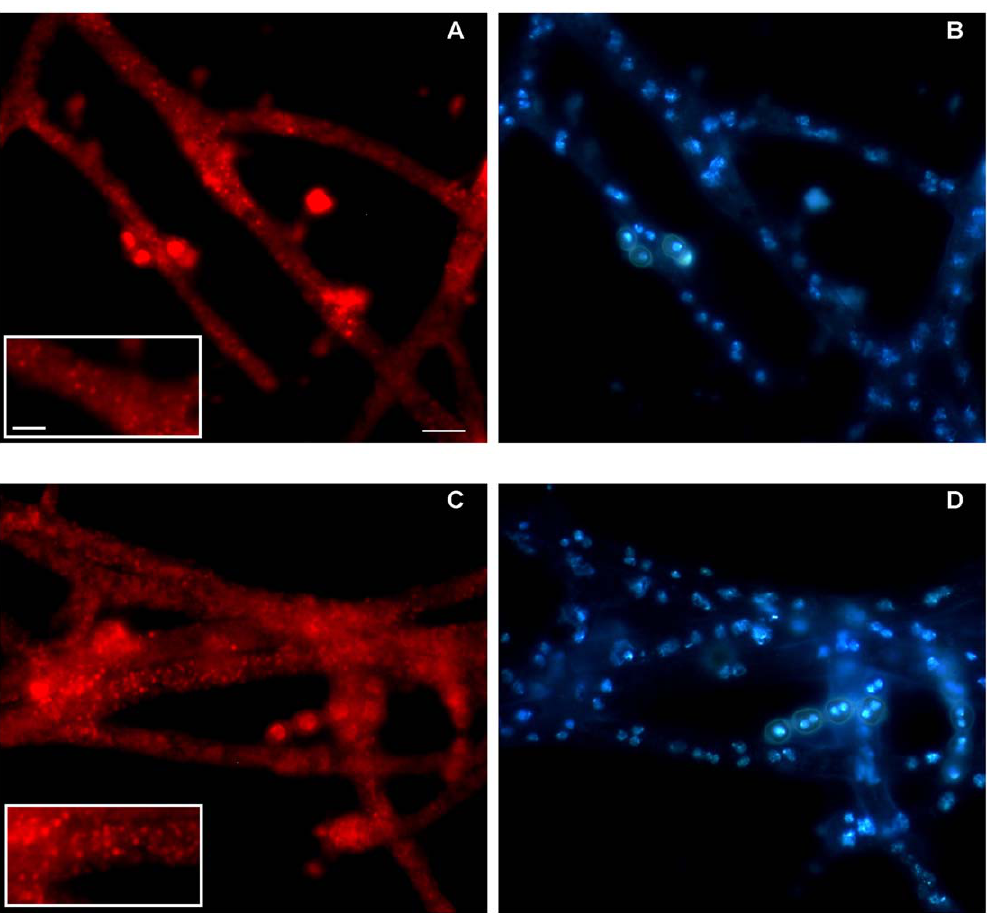
Figure 3. Fluorescence analysis of AFDsRED and AfP33 strains. The fluorescence analysis was performed to compare the presence of peroxisomes (red) between (A, B) AfDsRED and (C, D) AfP33 strains. Cells not expressing p33 displayed a punctate pattern of fluorescence (A and detail in the boxed area) corresponding to scattered peroxisomes whereas cells expressing p33 showed the presence of red spots revealing an increased number of peroxisomes (C and detail in the boxed area). Nuclei are stained with DAPI. Scale bars= 10 mm (A–D); 5 mm (boxed areas in A and C).